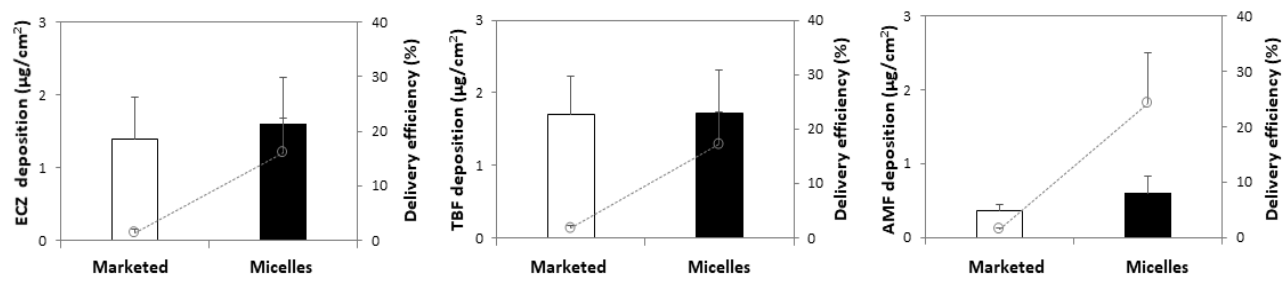
Figure 5. Comparison of ECZ, TBF and AMF delivery to the skin (left, middle and right panels) from marketed formulations and from the “tri-therapy” following formulation application under finite dose for 6 h (mean ± SD, n ≥ 5).